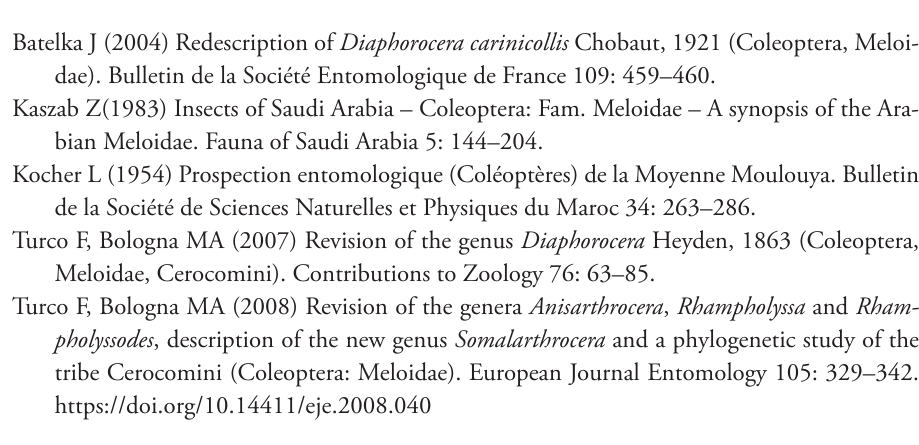
Pronotum distinctly narrow. Head and pronotum punctures usually sparse and shallow, surface among punctures shiny, almost smooth. Temples in dorsal view squared and slightly longer; in lateral view the edge between vertex and occiput sharper. Antennomere VIII ca. as long as wide and more squared ...... – Pronotum parallel but less narrow. Head and pronotum punctures usually dense and deep, surface among punctures shagreened. Temples in dorsal view more rounded and shorter; in lateral view the edge between vertex and occiput more rounded. Antennomere VIII wider than long and more trapezoidal